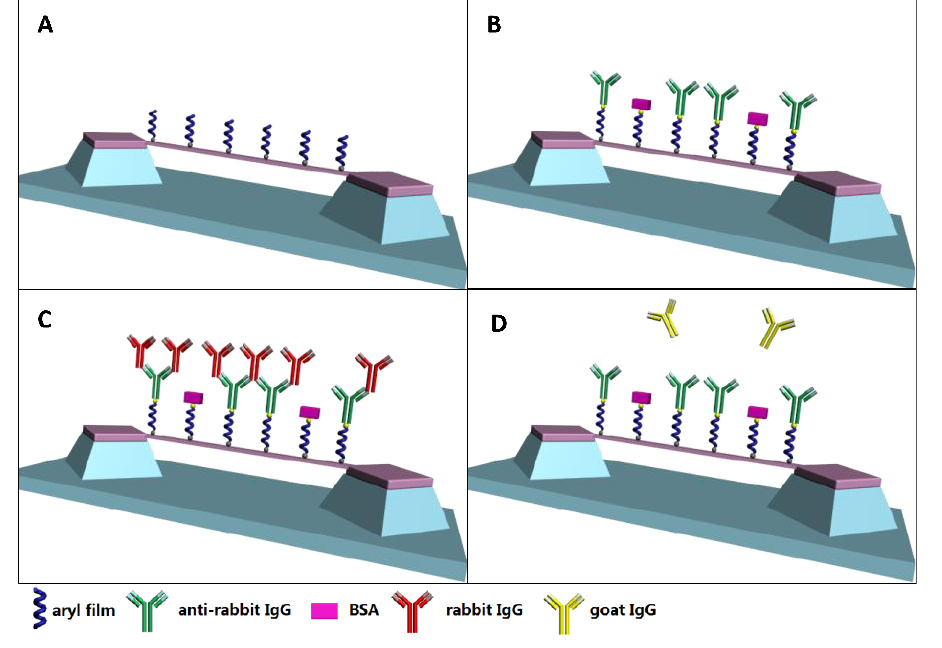
Figure 2. Surface modification and immobilization of molecular probe and target onto SiCN nanostrings. ( A ) SiCN resonators were modified by aryl diazonium salt; ( B ) The probe anti-rabbit IgG antibody was immobilized onto the diazonium layer; ( C ) The target rabbit IgG binds to the probe rabbit IgG antibody; ( D ) The control goat IgG does not bind to the probe rabbit IgG